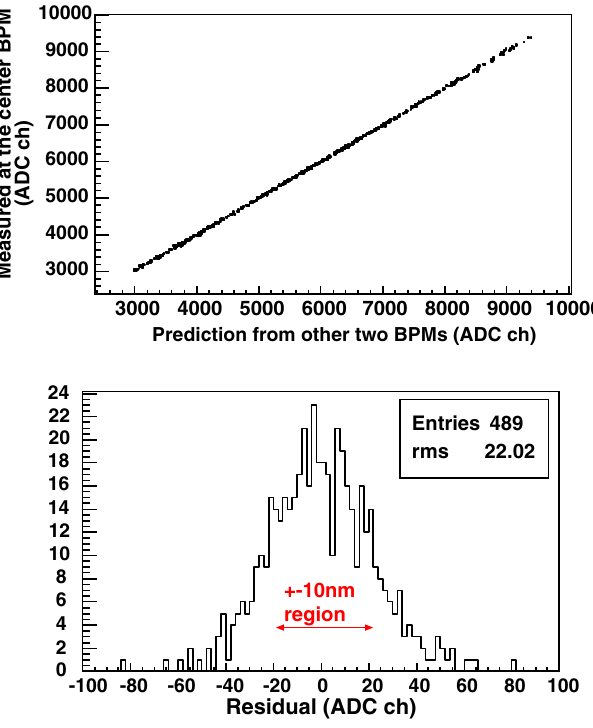
FIG. 17. (Color) Resolution measurement data. The top figure shows a scatter plot of the prediction and measurement. The bottom figure is the distribution of the residual of the prediction.